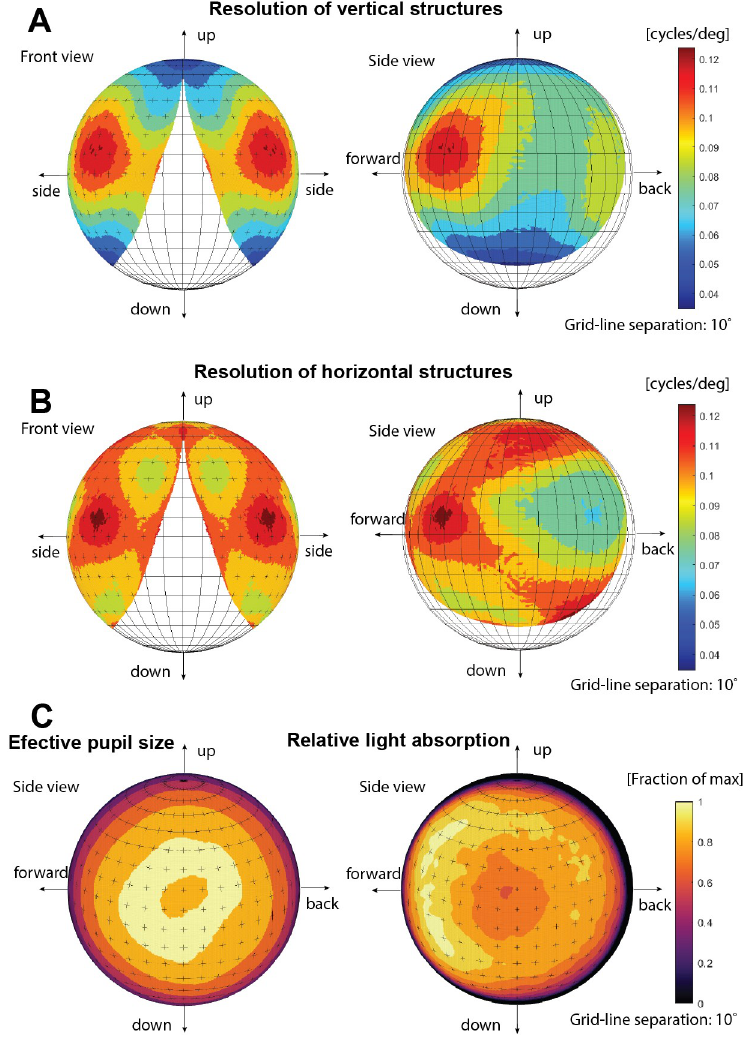
Fig 6. Resolution in different parts of the visual field. (A,B) Computed resolution (spatial cut-off frequency) for vertical and horizontal structures. The cut-off frequency was determined by Fourier transform of the individual photoreceptor sensitivity functions and determining the FWHM of the response in the vertical and horizontal direction in the Fourier plane. The field of view is displayed from both lateral and frontal directions. The visual field does not extend into the contralateral side, and consequently there is no binocular overlap between the two eyes. (C) Effective pupil area and computed relative light absorption by the retina in different viewing